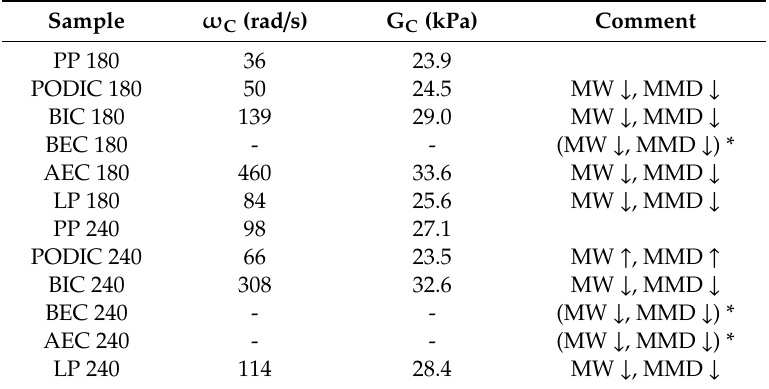
Table 3. Summary of the rheological data from the frequency sweep measured at 230 ◦